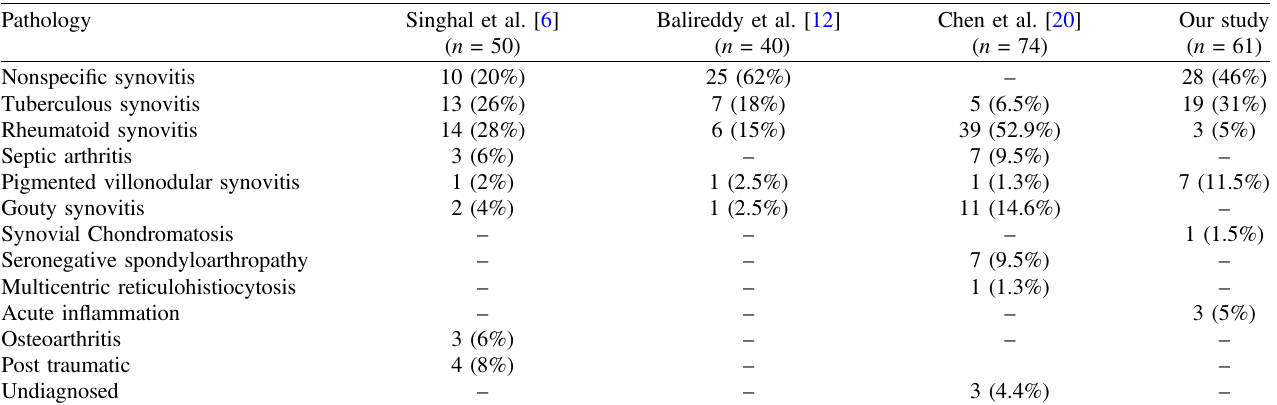
Table 5. Comparison of results of histopathological diagnosis to other studies in the